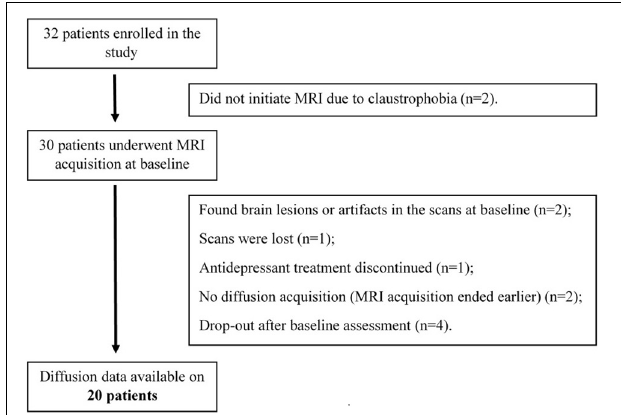
FIGURE 1 | Detailed information on subject recruitment and exclusion. Thirty-two patients were enrolled in the study. From those, 30 patients completed MRI acquisitions and psychological assessment, but only 20 were included in the final analyses.